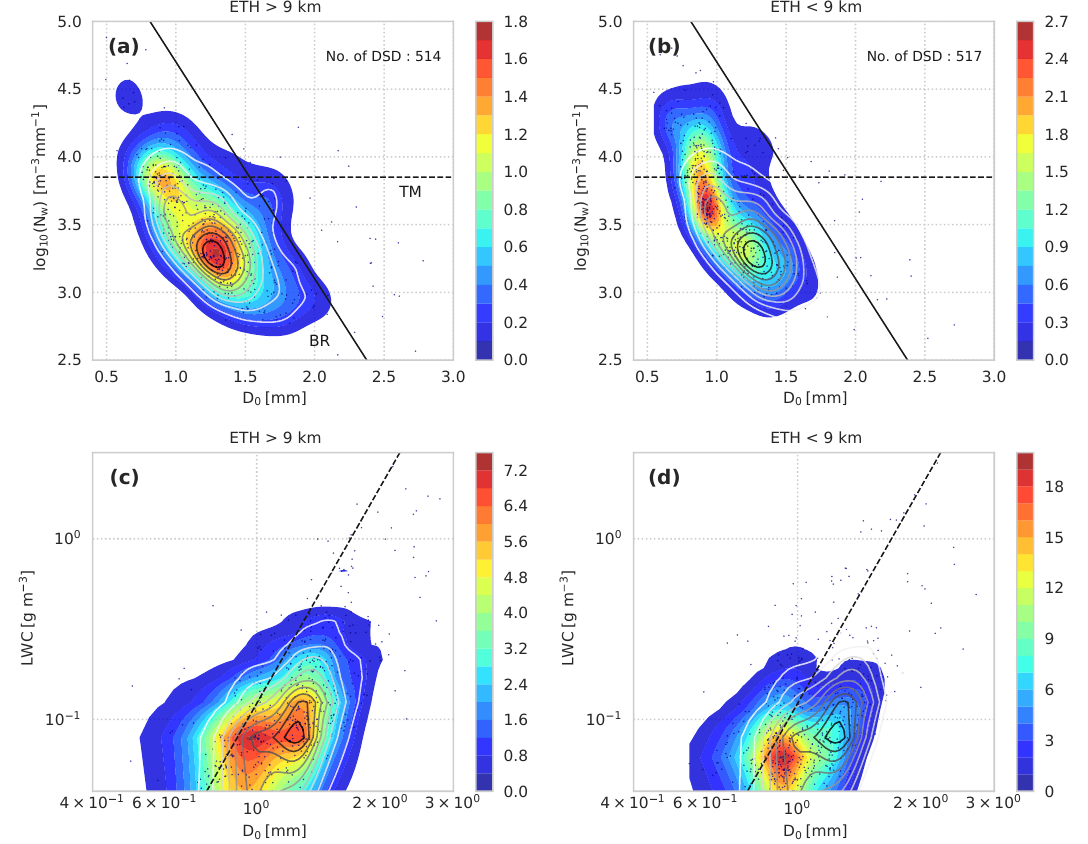
Figure 11. Scatter plots of log 10 ( N w ) versus D 0 and LWC versus D 0 for RWP-based stratiform DSDs (density on the color scale) and for ETH < 9km (a, c) and ETH > 9km (b, d) DSDs. The overlaid black contours represent the RWP-based classifications for stratiform clouds with bright band precipitating